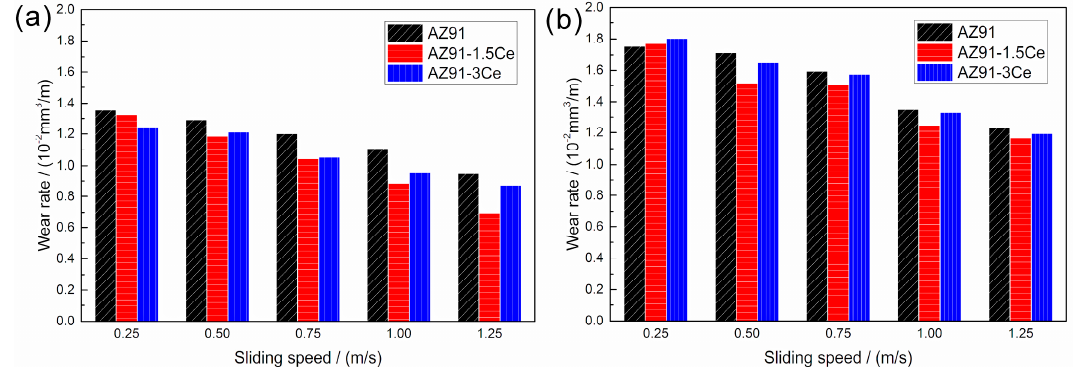
Figure 7. Wear rate values for ( a ) 10 N, ( b ) 20 N loads.